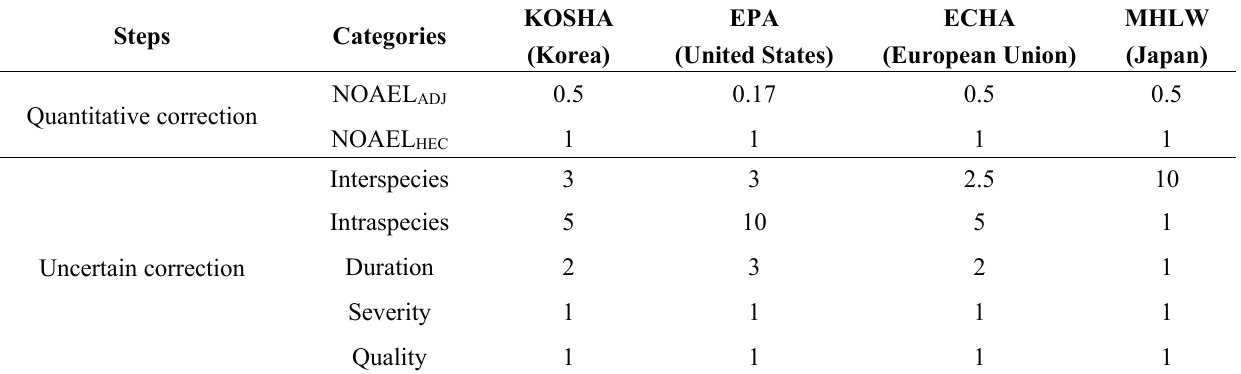
Table 1. Correction factors for deriving the reference concentration for work.